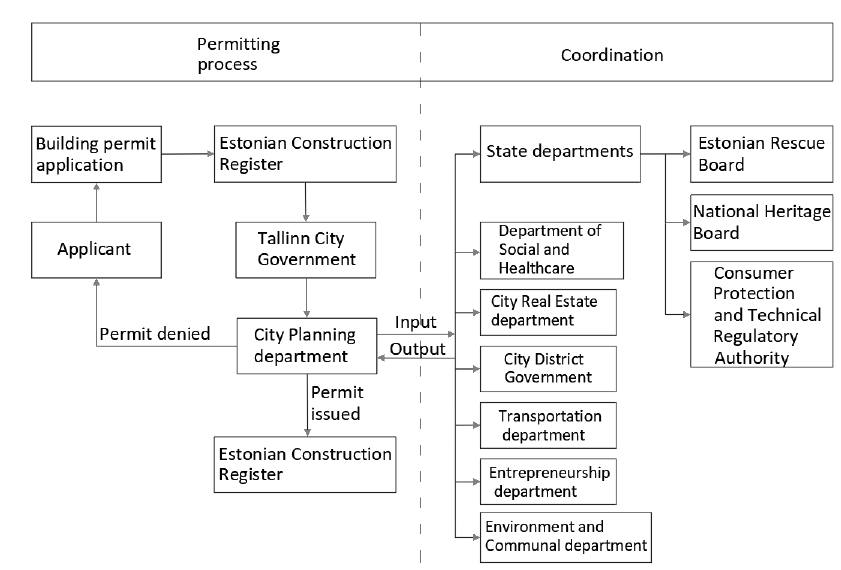
Figure 1. The structure of Tallinn City Government in building permitting